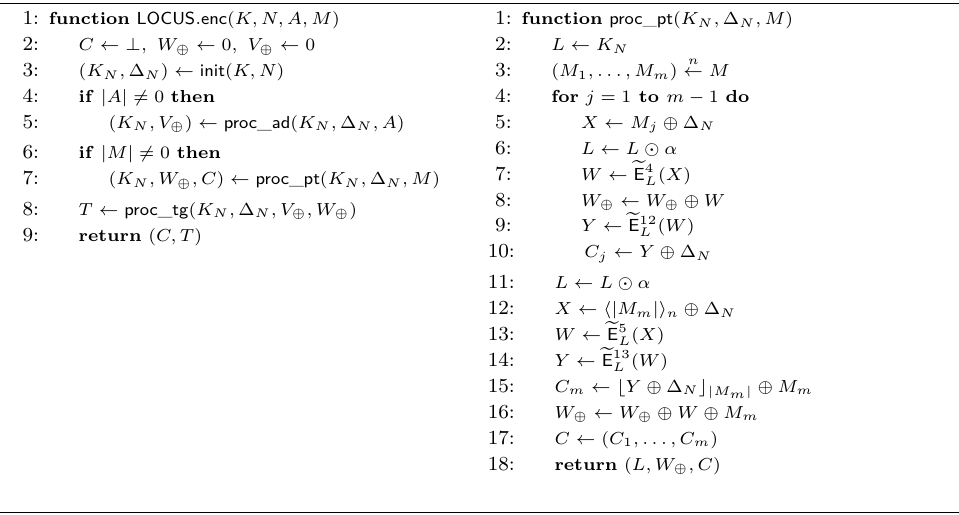
Algorithm 2 The encryption algorithm of LOCUS . The subroutines proc_ad and proc_tag are identical to the one used in LOTUS